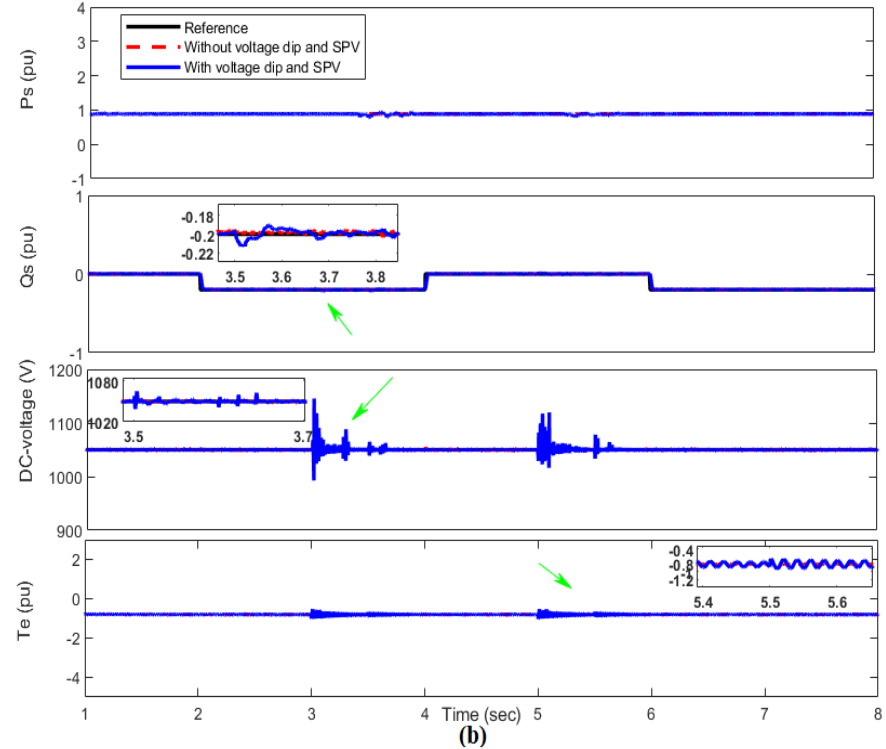
Figure 14. Simulation results of different control dynamics under unbalanced grid voltage conditions and the influence of SPV: ( a ) PI controller; ( b ) STA-SOSM controller.